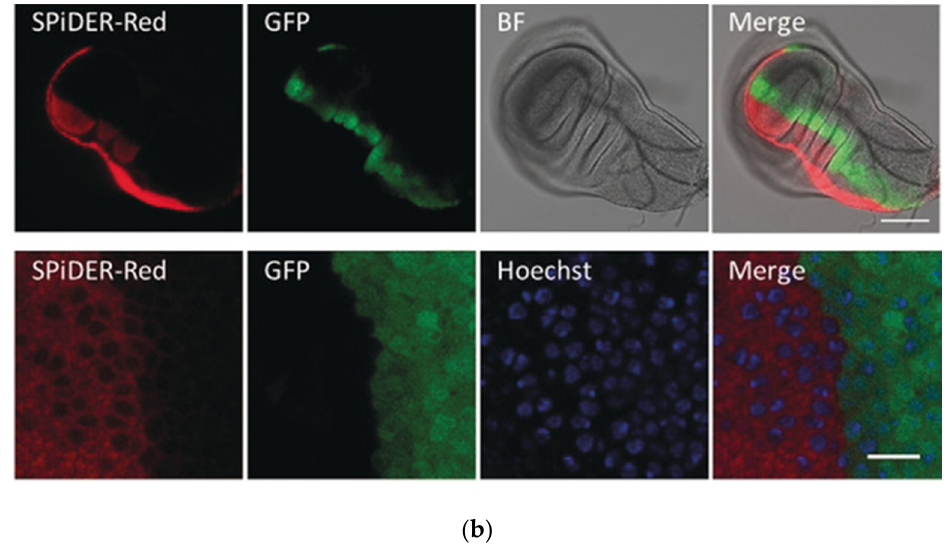
Figure 2. SPiDER-Red- β Gal for the sensing of LacZ( + ) cells: ( a ) Enzymatic activation of SPiDER-Red- β Gal by β -galactosidase; ( b ) Fluorescence imaging of live en-lacZ / dpp -GFP Drosophila third larval wing discs after incubation with SPiDER-Red- β Gal (top) and additional Hoechst 33342 (bottom). Adapted with permission from [102]. Scale bars = 10 µm.